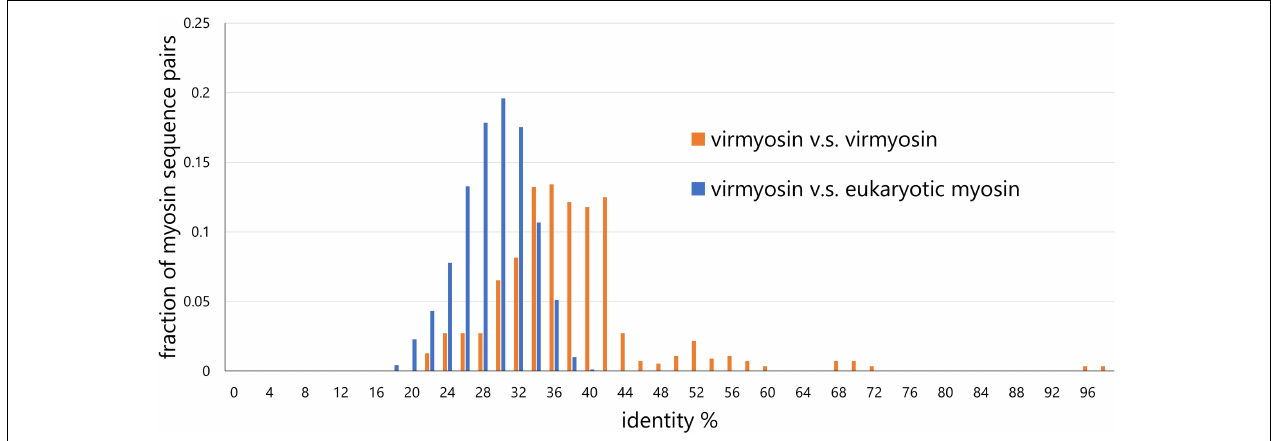
FIGURE 4 | Distributions of pair-wise myosin sequence similarities within the NCLDVs (virmyosin vs virmyosin) and between NCLDVs and eukaryotes (virmyosin vs eukaryotic myosin). This graph shows that the mean value of myosin similarity within NCLDVs is higher than that between NCLDVs and eukaryotes.